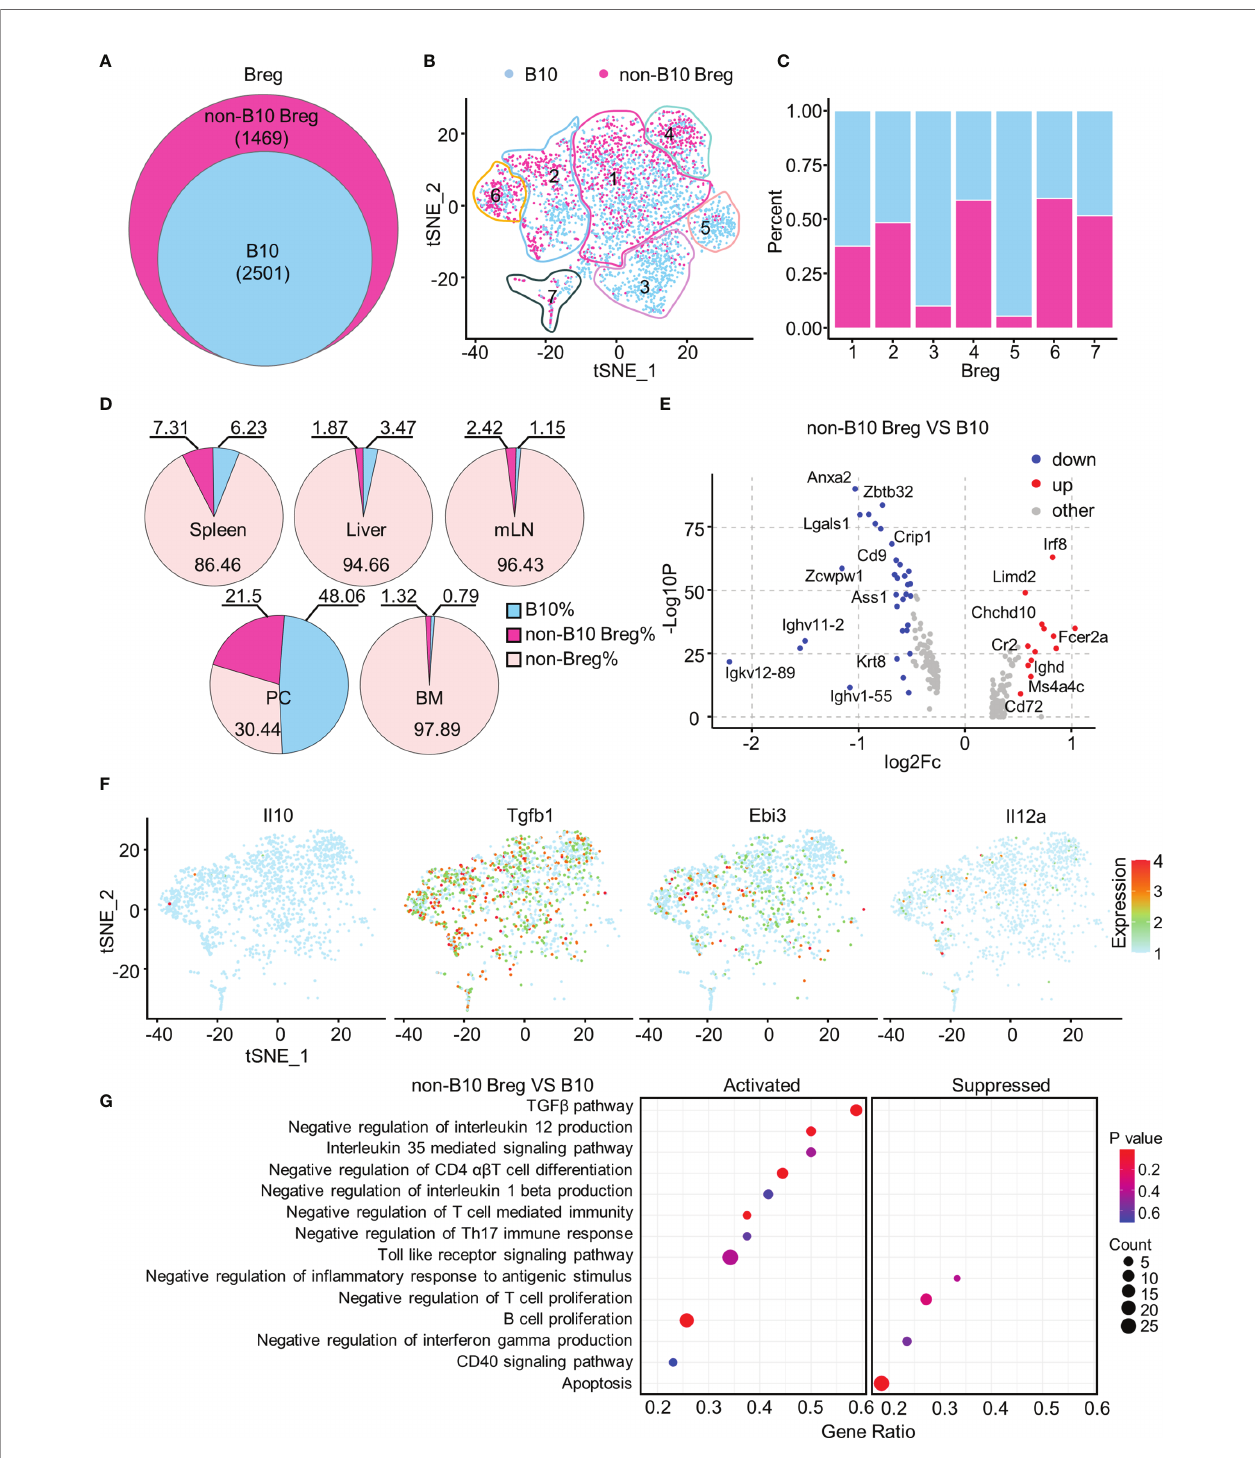
FIGURE 5 | Functionally speci fi c non-B10 versus B10 cells among Breg cells. (A) Venn diagram showed the B10 and non-B10 cells in Breg cells of all organs. (B) t-SNE plots of the B10 and non-B10 cells in Breg cells. (C) Proportion of B10 and non-B10 Breg cells in every Breg cell cluster. (D) Percent of B10 and non-B10 Breg cells in spleen, liver, mLN, PC, and BM. (E) Volcano plot displayed the DEGs between B10 and non-B10 Breg cells from all organs. (F) t-SNE plots of the normalized expression of Il10 , Tgfb1 , Ebi3 , and Il12a in non-B10 Breg cells of all organs. (G) GSEA analysis of B10 and non-B10 Breg cells of all